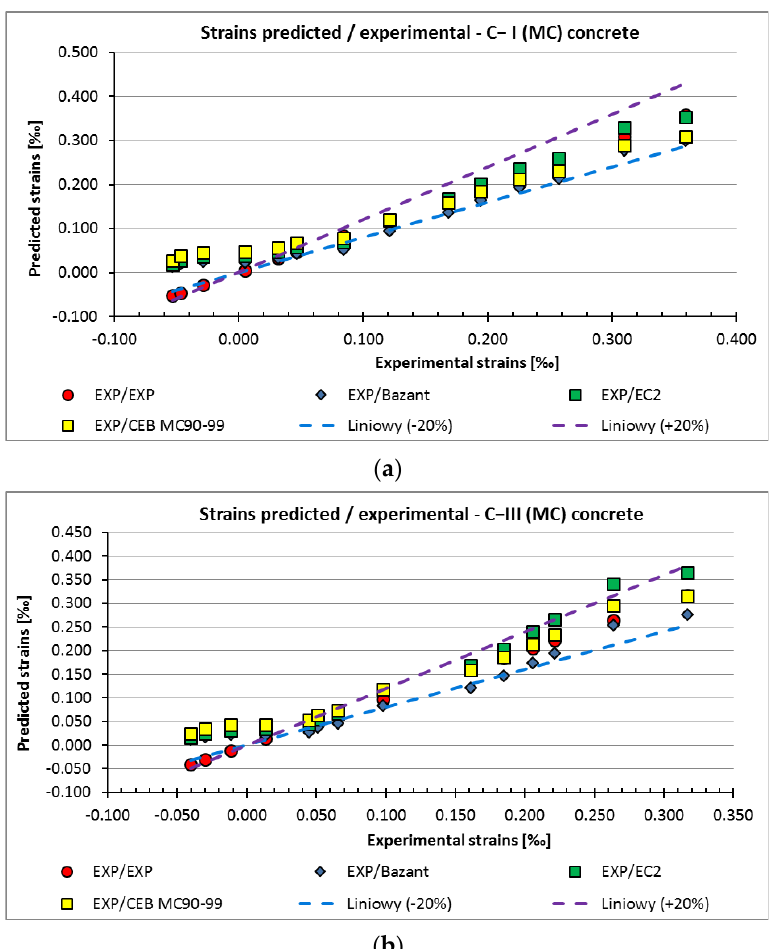
Figure 5. The strains in the pre-cured samples: ( a ) C − I (MC), ( b ) C − III (MC).